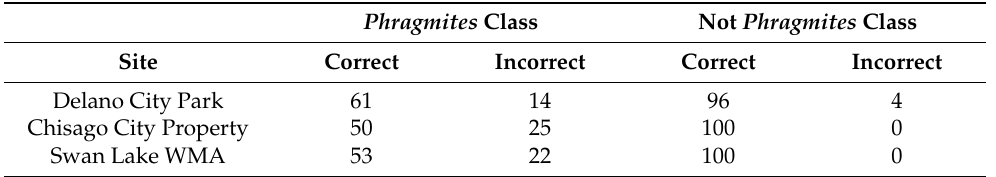
network classification without the post-ML OBIA rule